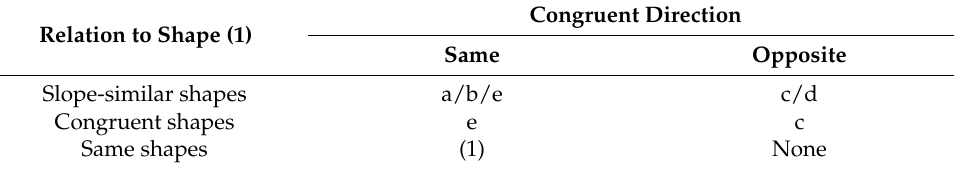
Figure 2. Shapes formed by two line segments. Table 2. Relationship of shapes a–e to shape